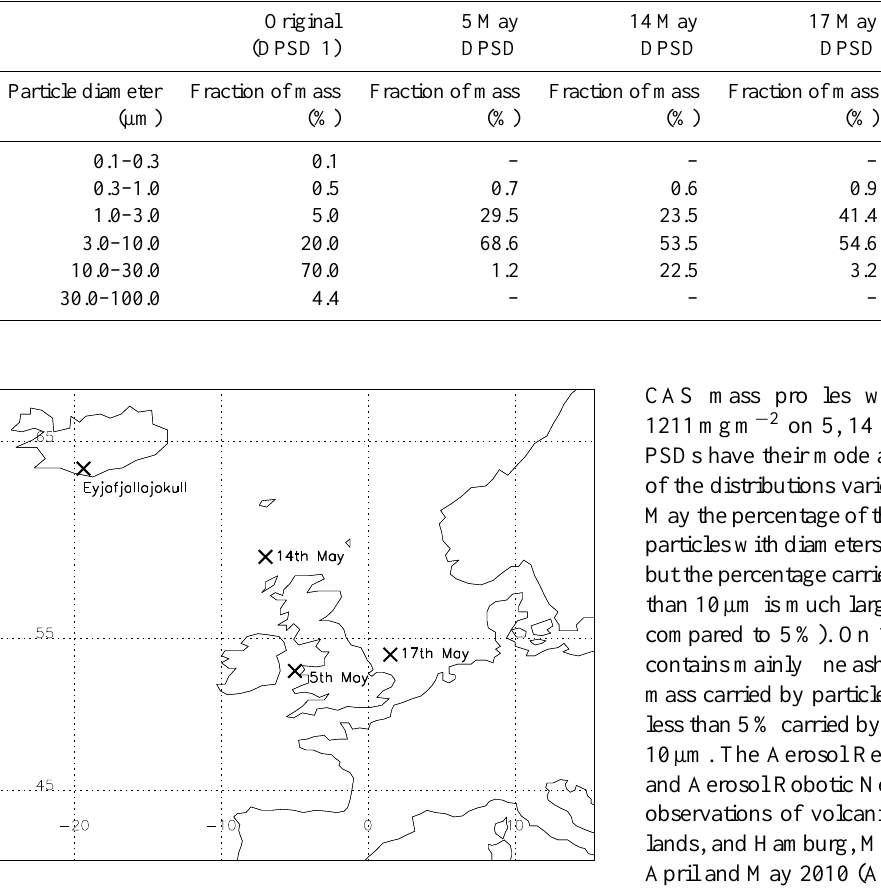
Fig. 1. Location of FAAM aircraft profiles in relation to Eyjafjallaj¨okull volcano vent.